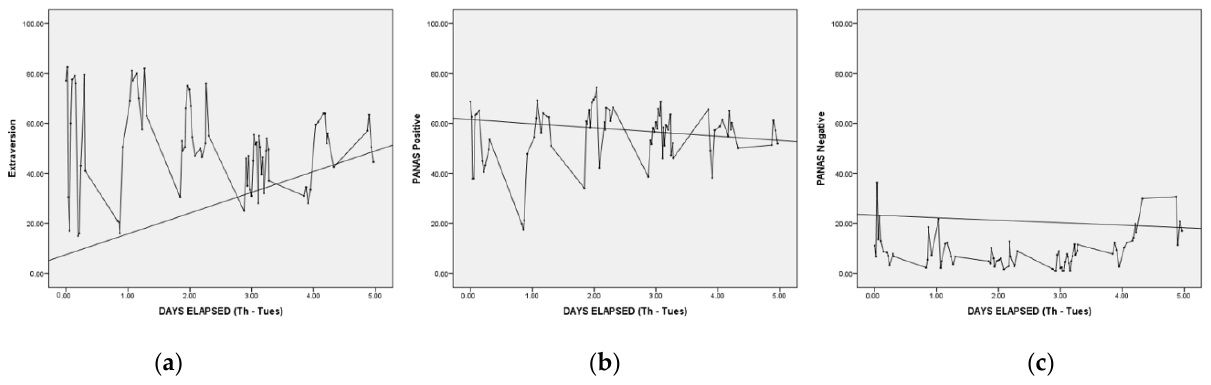
Figure 2. ( a – c ). Variability in Extraversion and PANAS Positive Affect, Bob. Notes: Straight line connects pre and post paper and pencil measurements. All measures expressed on 1-to-100 scales.